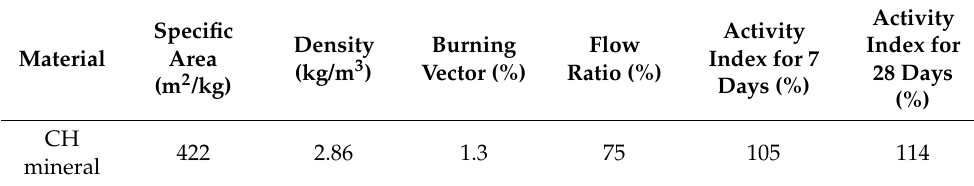
Table 4. Performance indices of CH mineral powder.